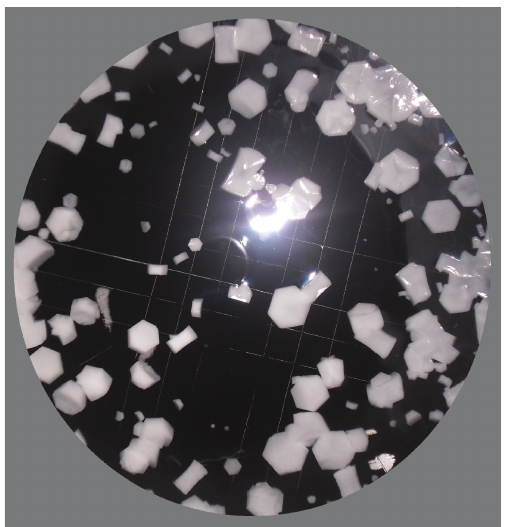
Figure 6: Measurement of ice nuclei from isothermal cloud cham- ber at